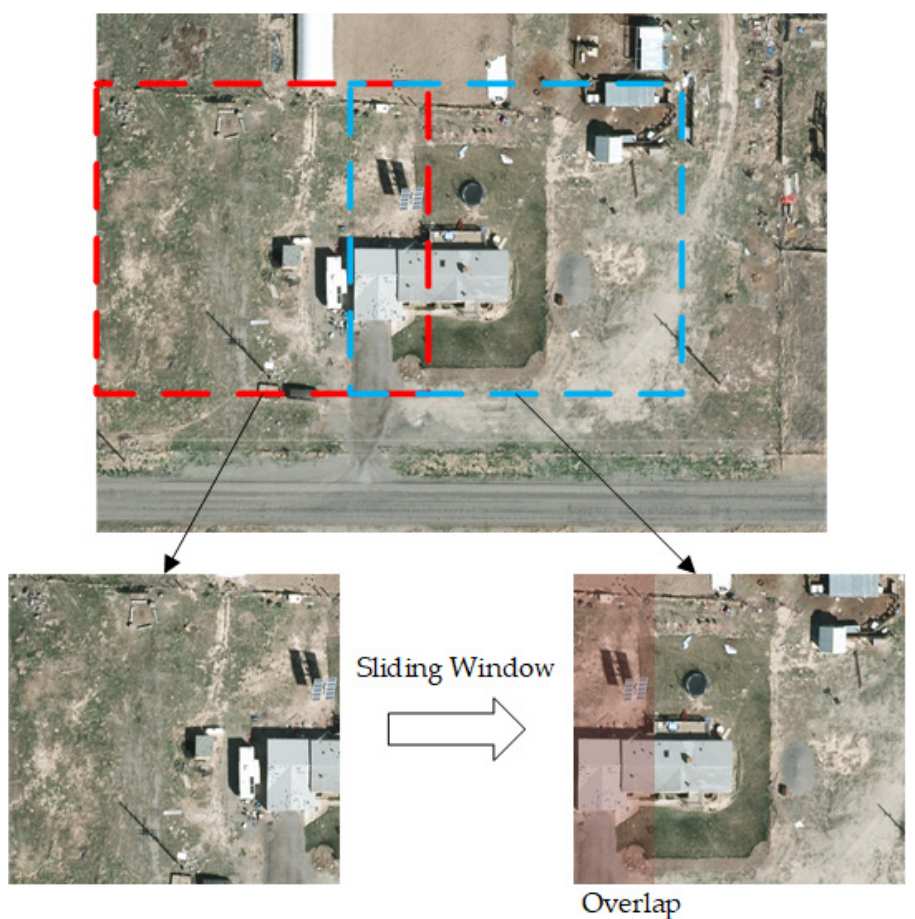
Figure 3. Training sample clipping by sliding window in remote sensing images.